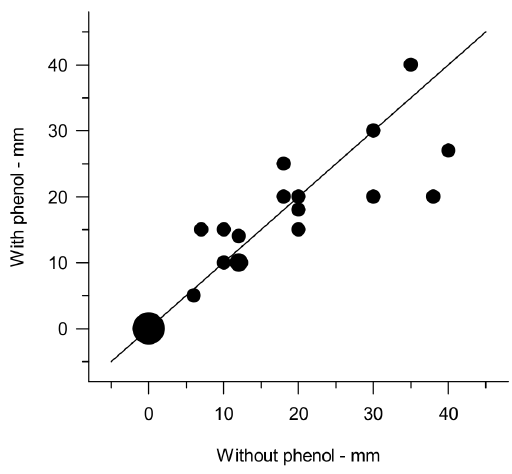
Figure 4. Induration 2 days after injection of unpreserved and phenol preserved C-Tb (0.1 m g) to TB patients. Line of identity is shown. Area of dot indicates number of patients with dot at (0.0) representing 7 participants. N=24.